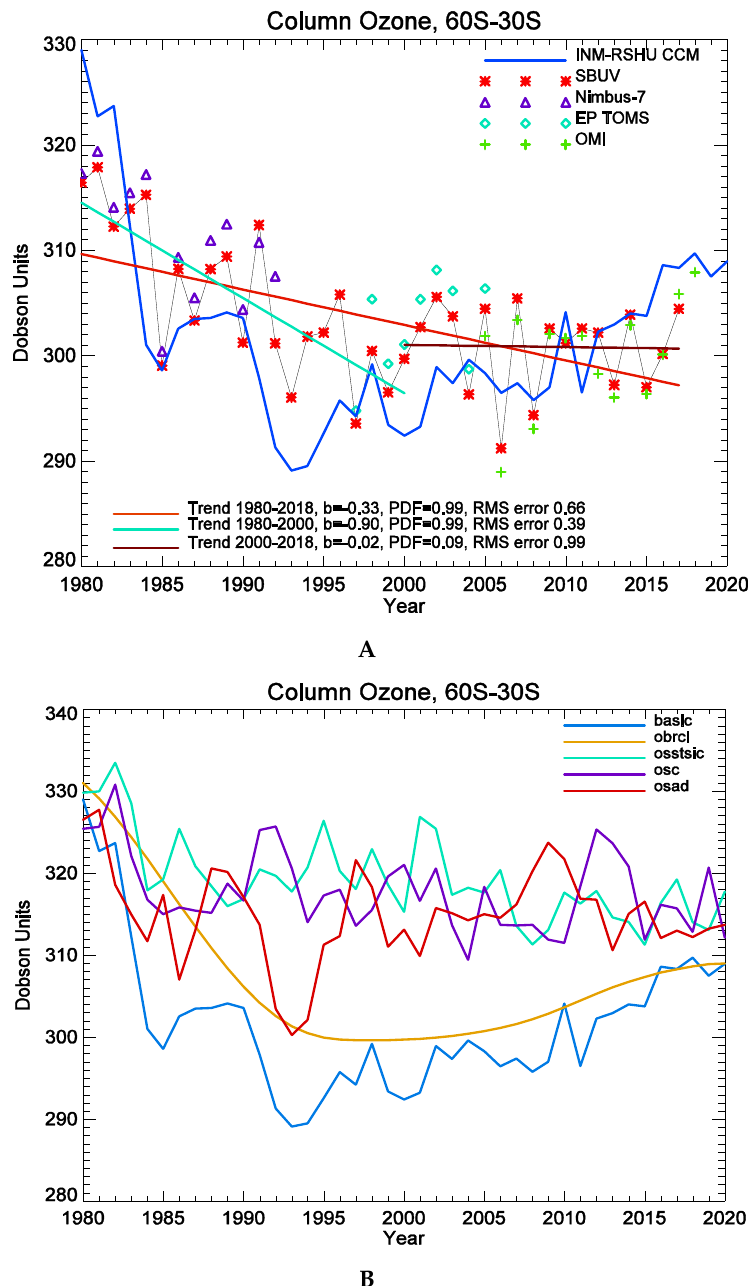
Figure 4. Interannual variability of column ozone in the southern mid-latitudes: ( A ) Results of satellite measurements (solar backscattering ultraviolet (SBUV), Nimbus-7 Total Ozone Mapping Spectrometer (TOMS), Earth Probe (EP) TOMS, and the Ozone Monitoring Instrument (OMI)) and numerical modeling (chemistry—climate model of the Institute of Numerical Mathematics and the Russian State Hydrometeorological University) with an assessment of trends (b—coefficient of linear regression) and their significance (PDF—probability density function, and RMS—root mean square error); ( B ) results of numerical modeling under scenarios with a separate action of influencing factors: basic—all factors’ interannual variabilities are taken into account, obrcl—only the surface emissions of bromine and chlorine-containing gases’ interannual variability is taken into account, osstsic—only sea surface temperature and sea ice coverage interannual variabilities are taken into account, osc—only solar radiation’s interannual variability is taken into account, osad—only sulfate aerosol density’s interannual variability is taken into account.